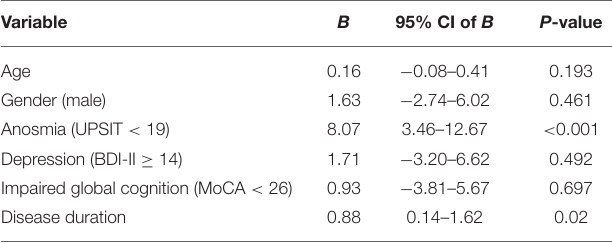
TABLE 5 | Multiple linear regression results for MDS-UPDRS Part 3 score.